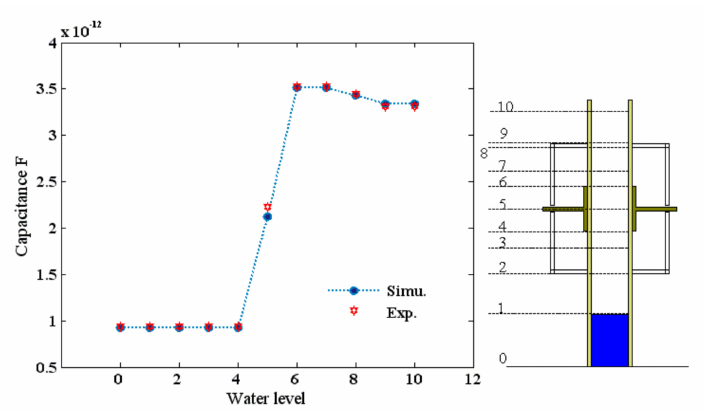
Figure A1. Vertical pipe test to compare between the simulated and experimental capacitance values as a function of changing the elevation of the water inside the